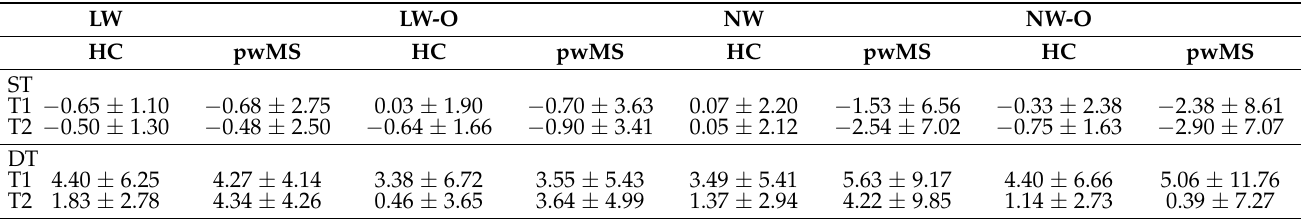
Table 2. Raw Mental Chronometry (R-MC) data.